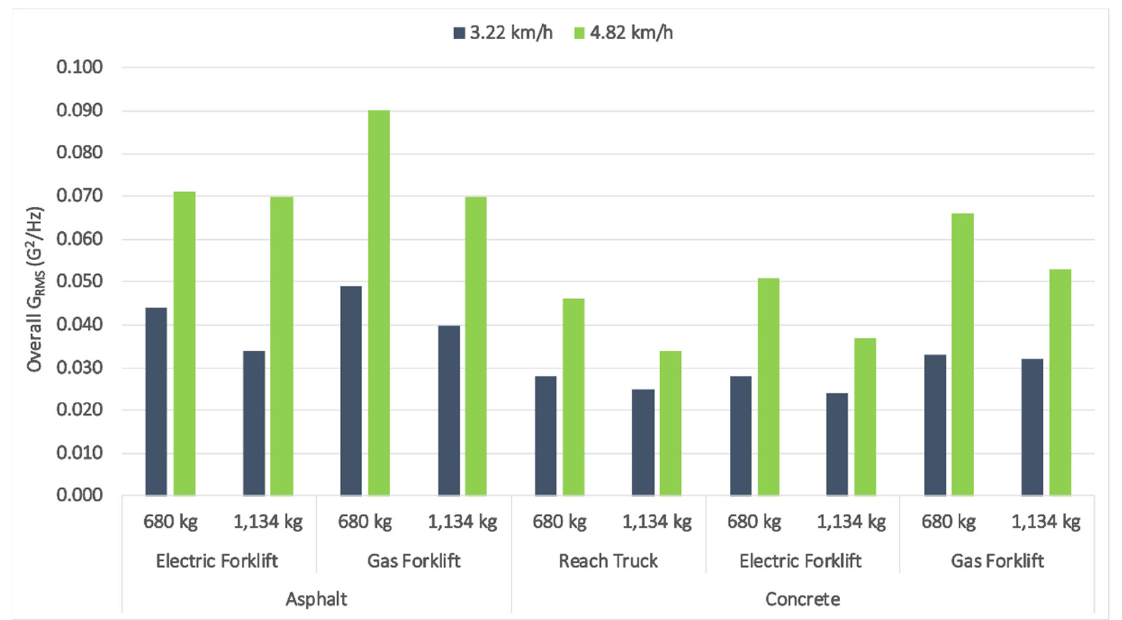
Figure 4. Overall vibration intensity measured at the carriage for each of the three forklifts (1–200 Hz).